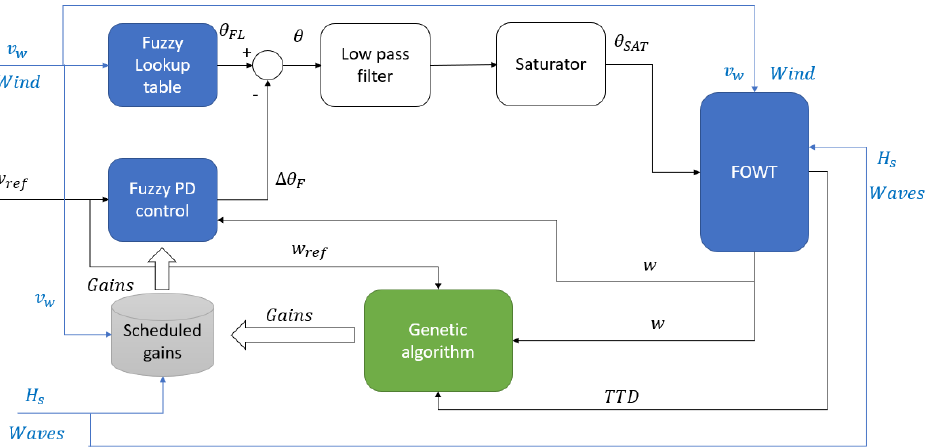
Figure 3. Hybrid intelligent controller with a fuzzy lookup table and a gain scheduling FLC tuned with GA.